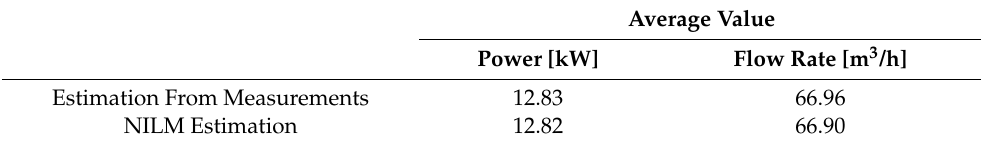
Table 6. Comparison between leakage estimation from measurements and from NILM.